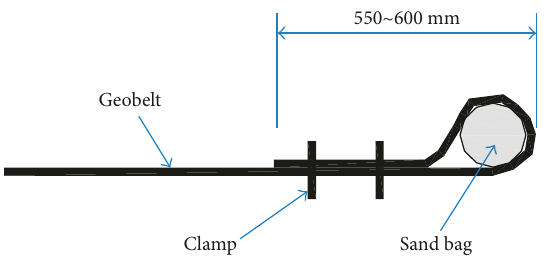
Figure 5: Fixing of geobelt